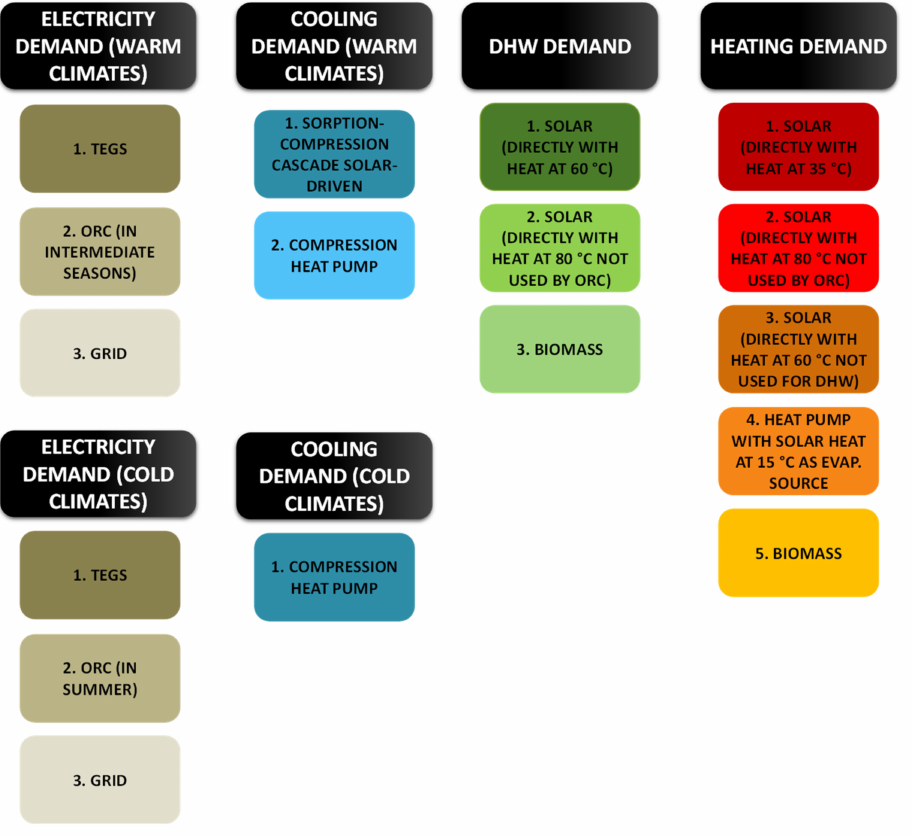
Figure 3. Prioritization of energy sources for each type of